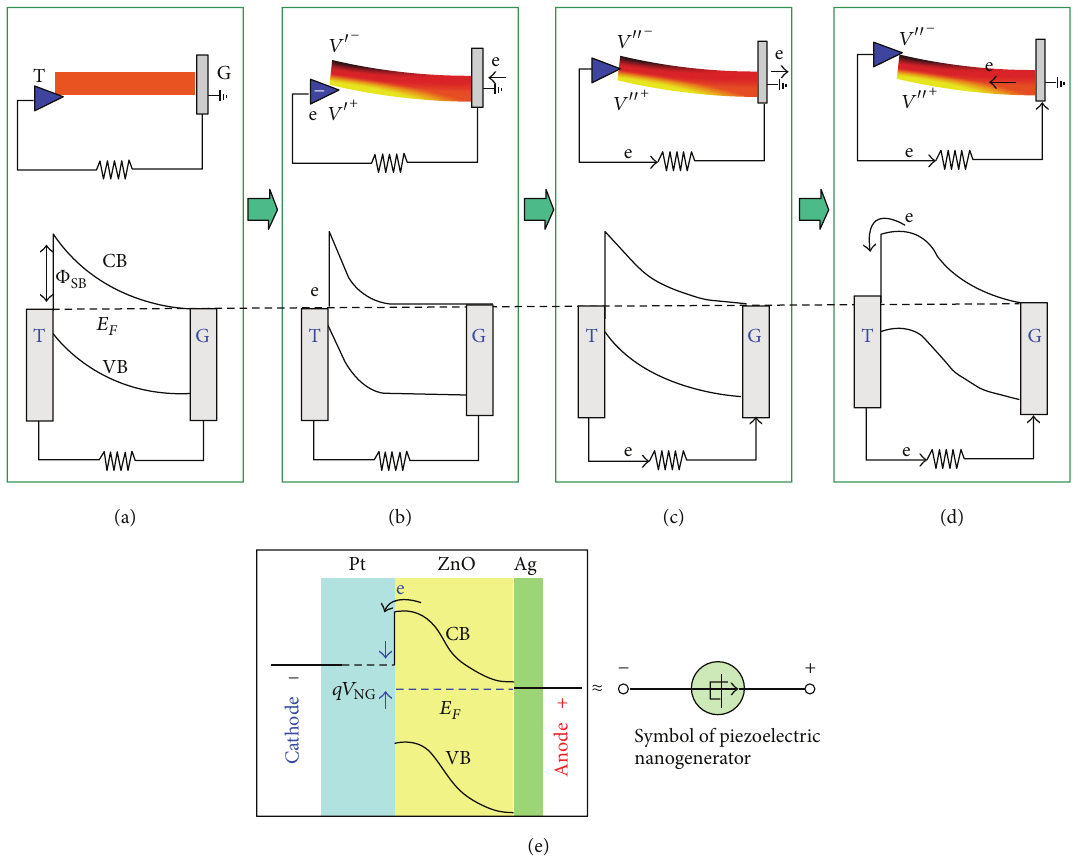
Figure 2: The band diagram for understanding the charge output and flow processes in a nanogenerator with lateral bending model. (a) Before bending; (b) nanowire bent by the tip with the tip point at the stretched surface; (c) tip scans across the nanowire and reaching the middle point; (d) tip reaching the compressed surface of the nanowire; (e) energy-band diagram for the nanogenerator, presenting the output voltage and the role played by the piezoelectric potential. (Reproduced from [20] with the permission from WILEY-VCH Verlag GmbH & Co. KGaA,